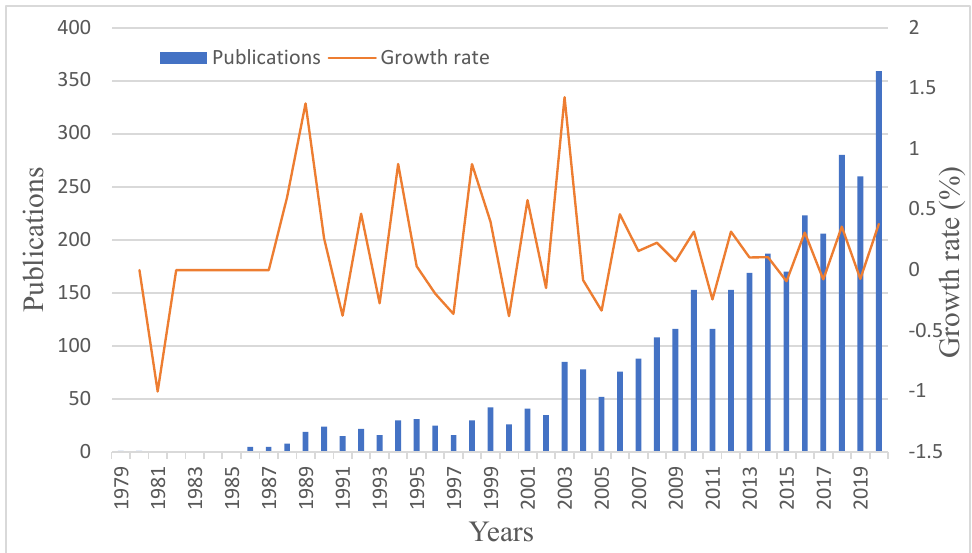
Figure 3. Yearly publication chart showing crisis and risk communication research between 1979 and 2020 (WOS and